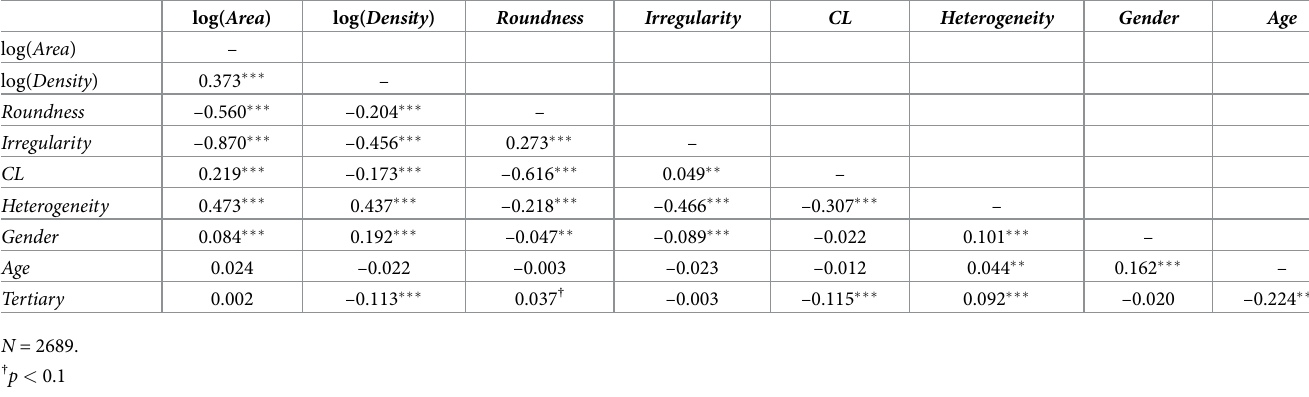
Table 3. Spearman rank correlation coefficient between the independent variables for the clusters with at least ten cells observed in